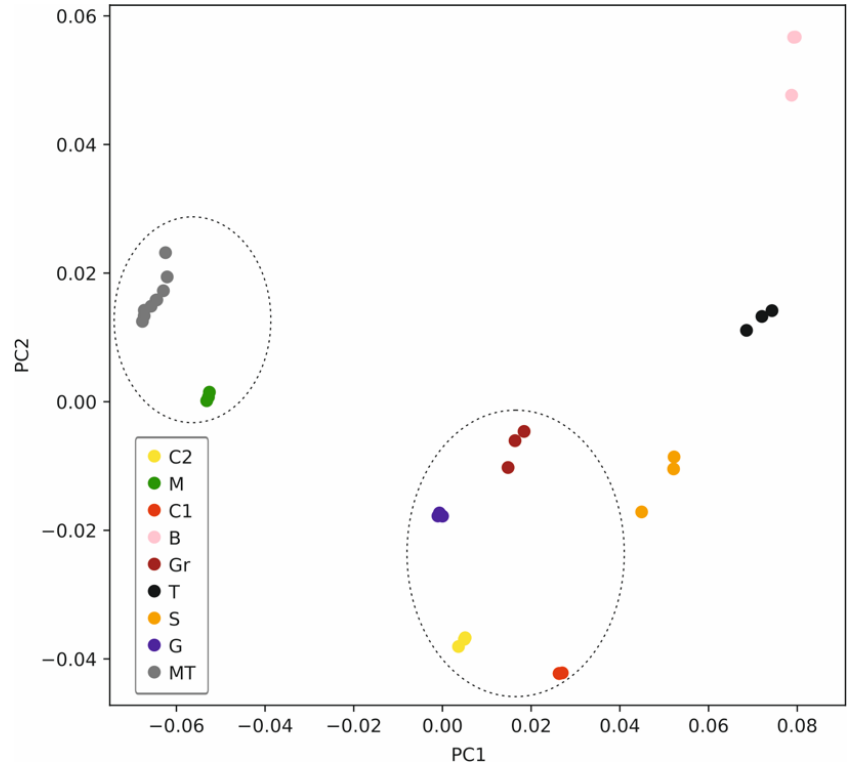
Figure 7. Principal component analysis. Plot of PC1 versus PC2 calculated for the pool of samples and including the three MT repetitions along the analysis.